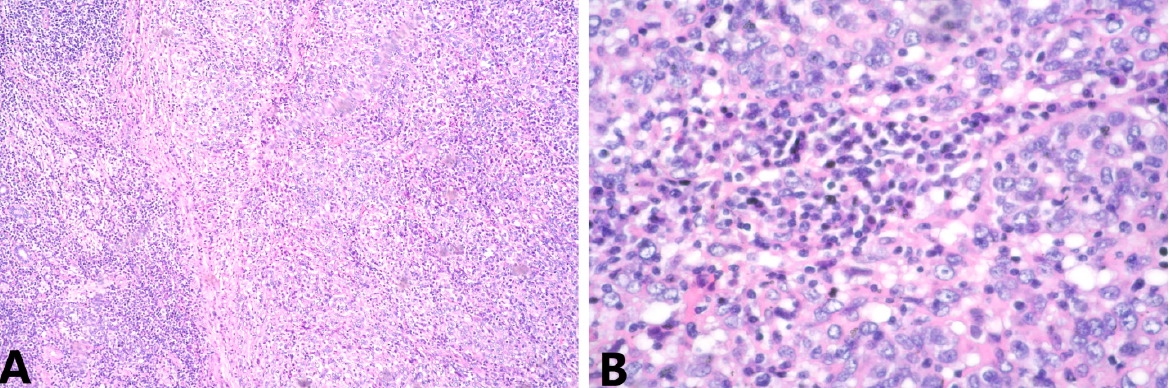
Figure 3. ( A ) Groups and strands of tumor cells, mixed with lymphoid stroma, HE 4x; ( B ) cells with pleomorphic vesicular nuclei, containing coarse chromatin, visible nucleoli and not abundant pale cytoplasm HE, 40x.